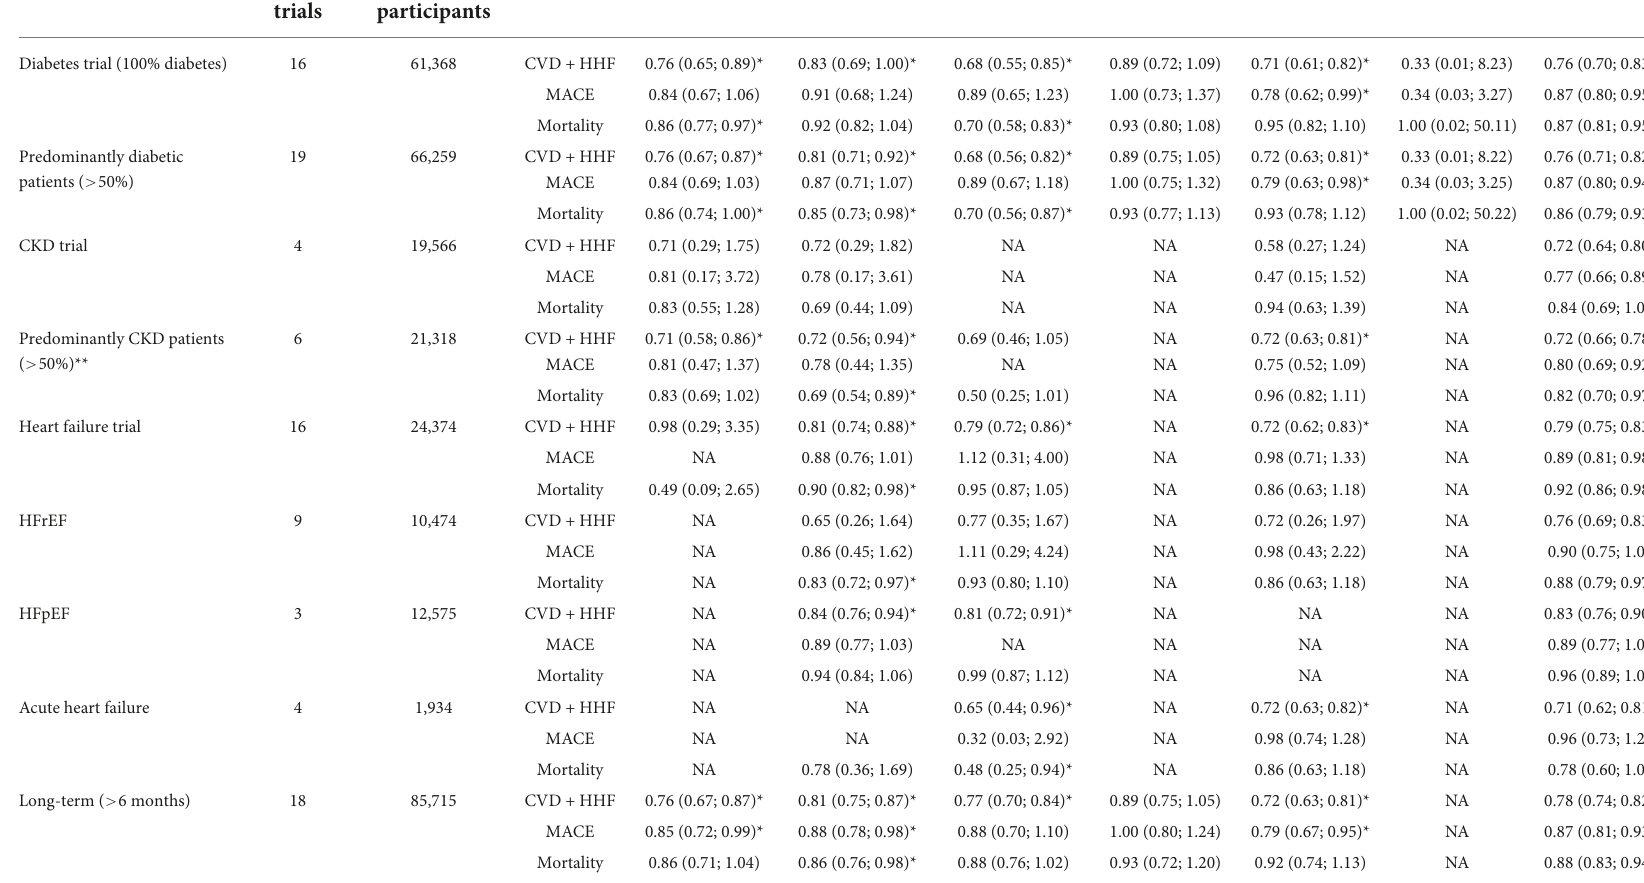
ThetabledepictsthenetworkeffectestimatesofthedifferentSGLT2inhibitorsandSGLT2inhibitorsasagroupcomparedtoplacebointhepredefinedsubgroups.Dataarepresentedasriskratio(95%confidenceinterval).*Markssignificanteffectestimates. **The subgroup is defined as studies with more than 50% of patients with eGFR < 60 ml/min/1,73 m 2 . SGLT2i, sodium-glucose transporter 2 inhibitors; CVD + HHF, cardiovascular mortality and hospitalization for heart failure; MACE, major adverse